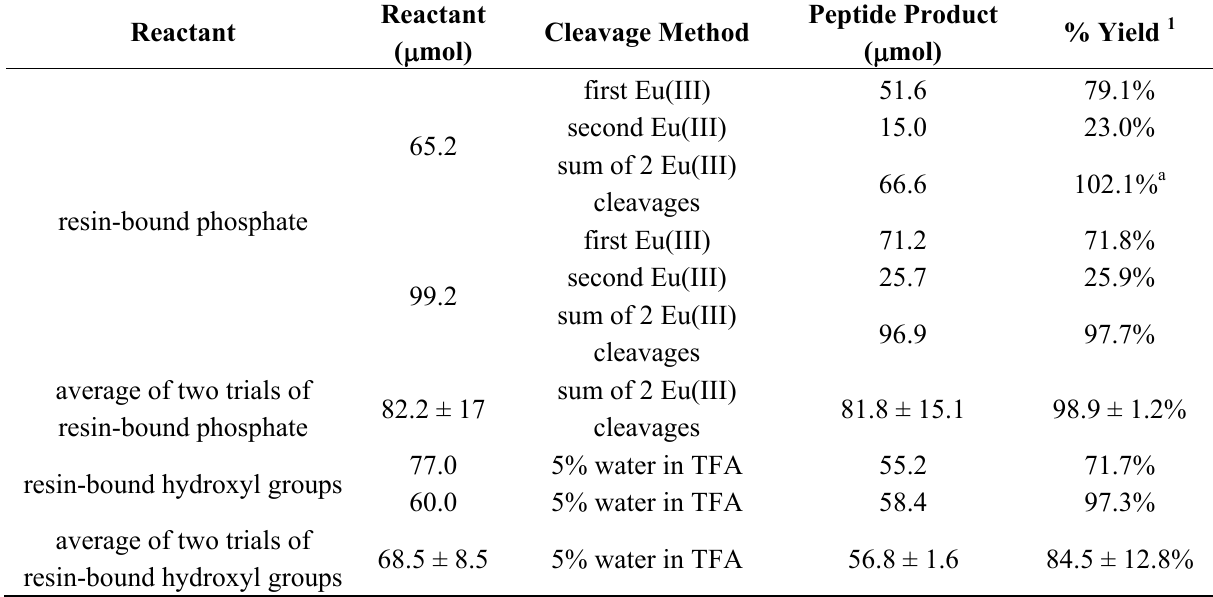
Table 2. The peptide recovery after treatments with Eu(III) in water or 5% water in